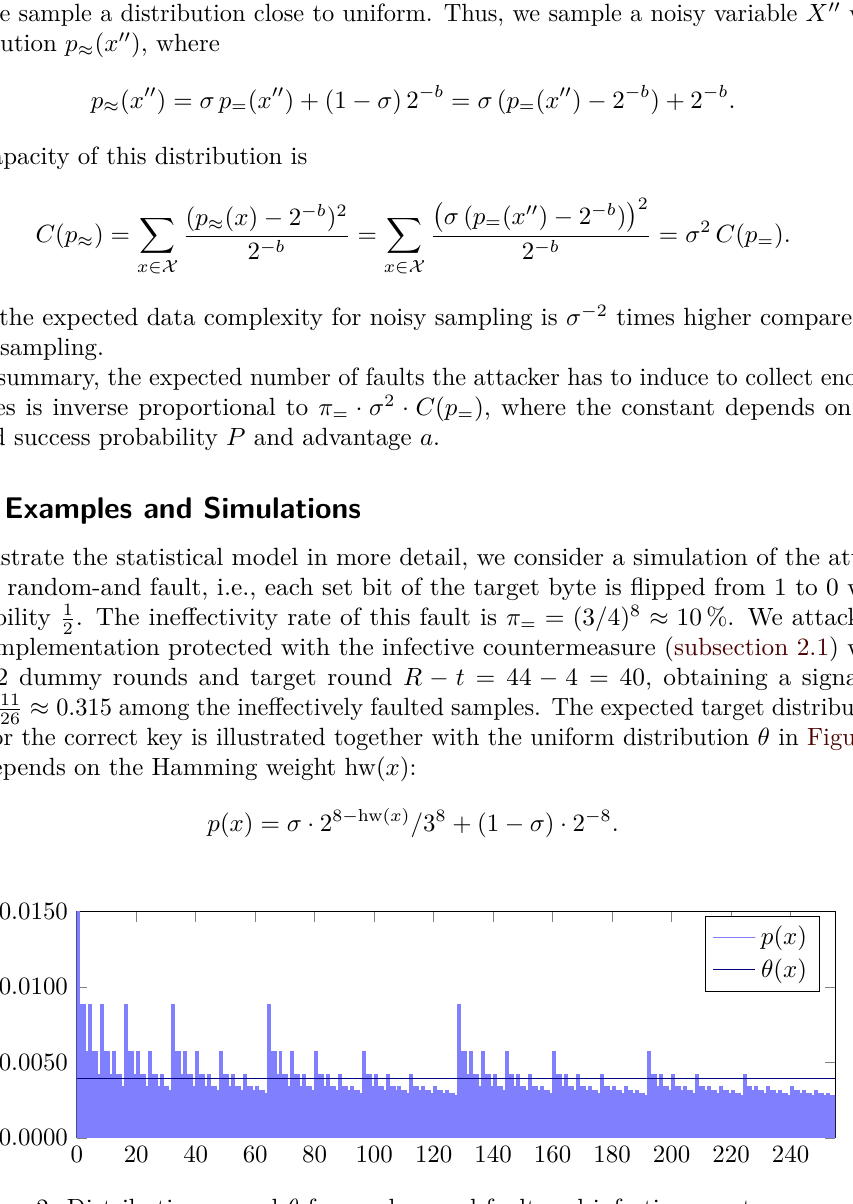
Figure 2: Distributions p and θ for random-and fault and infective